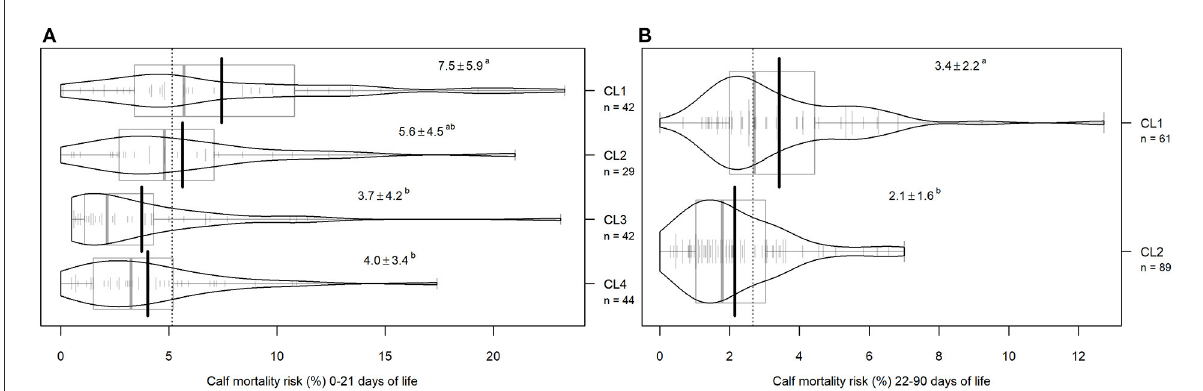
FIGURE3 Distribution of yearly calf mortality risk during the first 21 days of age (A) and 22–90 days of age (B) in each cluster (CL) formed in k-mean cluster analysis. Small vertical lines indicate calf mortality risk of a single respondent’s farm, bold vertical gray lines show cluster-based median, and bold black vertical lines denote cluster-based means. Gray squares illustrate the interquartile range and the dotted line marks the overall mean. Mean ± standard deviation is shown numerically for each cluster and different superscript letters indicate statistically significantly different clusters according to the Tukey post-hoc test.